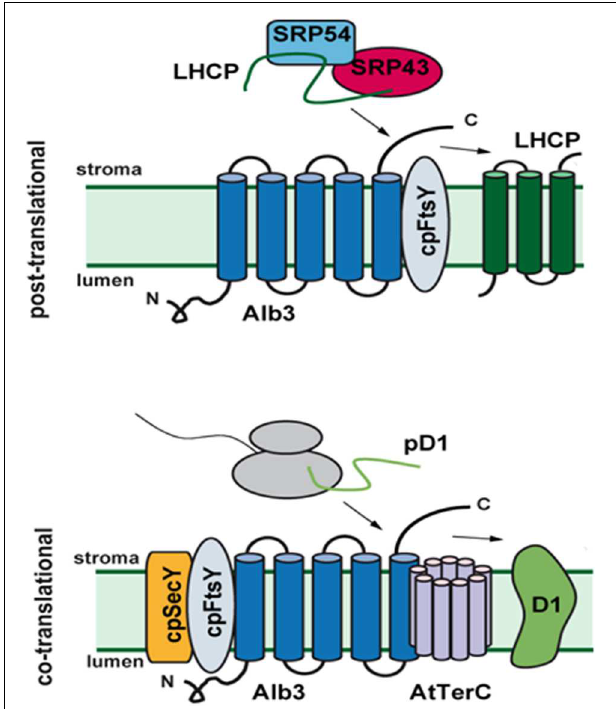
FIGURE 4 | Role of ALB3 and AtTerC in protein insertion into the thylakoid membrane. ALB3 functions in the insertion of the nuclear-encoded LHCPs, which are post-translationally targeted by the soluble SRP transit-complex (upper) . Co-translational integration of chloroplast-encoded proteins is also mediated by ALB3, which thereby acts in concert with TerC, cpSecY and cpFtsY (lower)